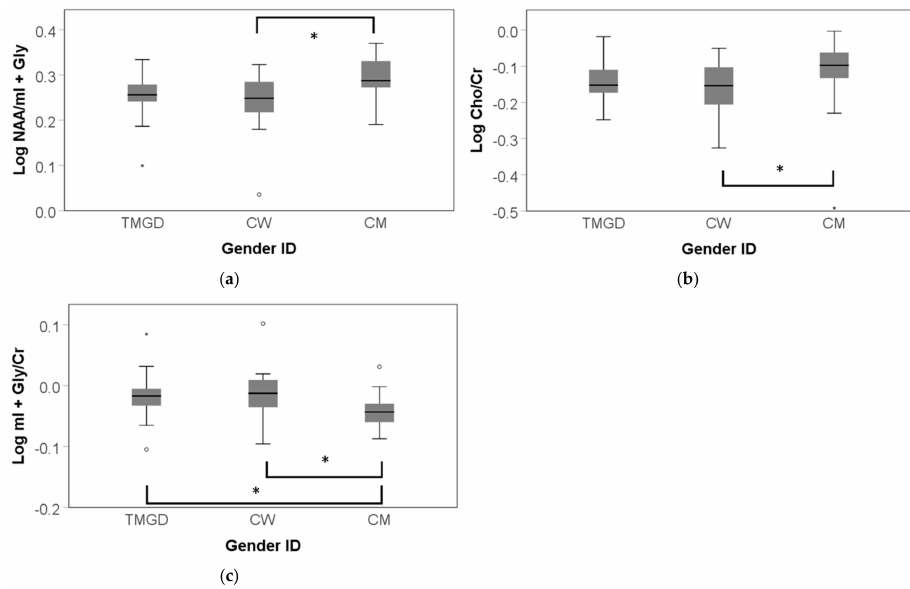
Figure 4. Group distributions of relative ratios in the lateral parietal cortex by gender identity (gender ID). TMGD = trans men with GD; CW = cis women; CM = cis men; * p = <0.05; mild outliers are marked with a circle ( ◦ ), extreme outliers